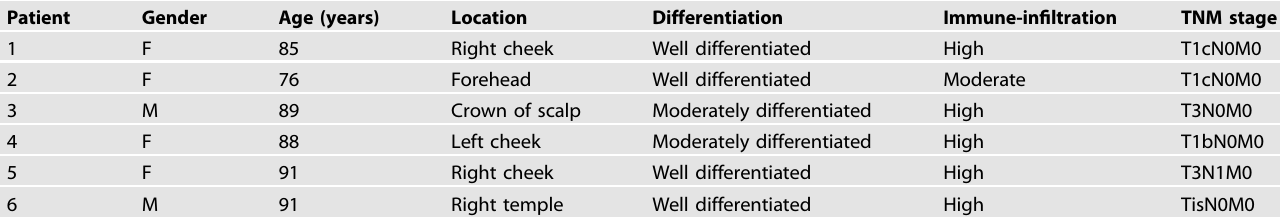
Table 1. Clinico-pathological characteristics of the patient